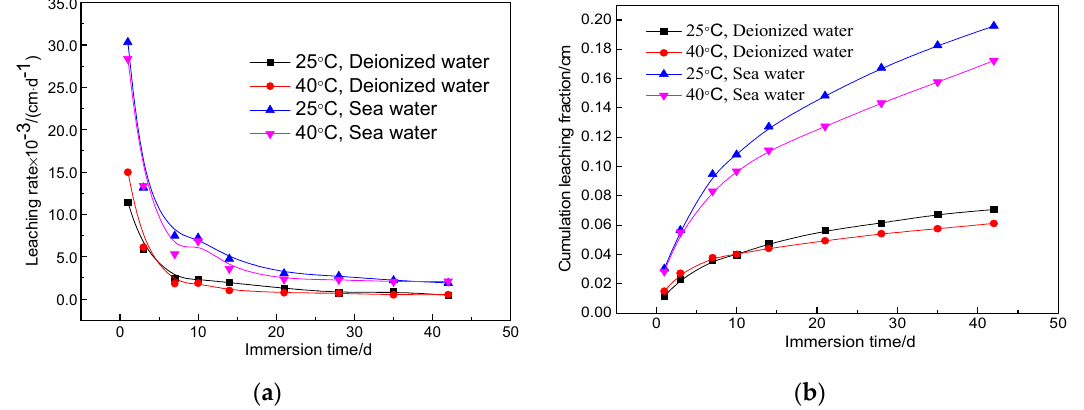
Figure 5. Leaching rate and cumulative fraction leached curves of the MgO–SiO 2 –H 2 O solidified bodies (water–cement ratio, 0.65; Sr 2+ content, 1.6 wt.%) under different leaching conditions. (a) Leaching